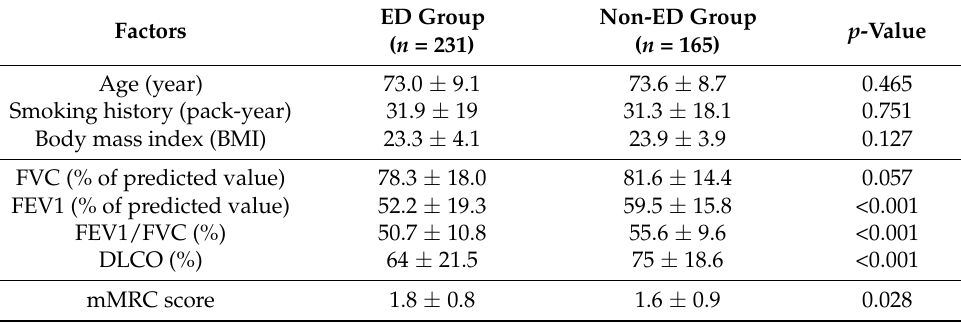
Table 2. Lung Function and Exercise Capacity of the ED and Non-ED